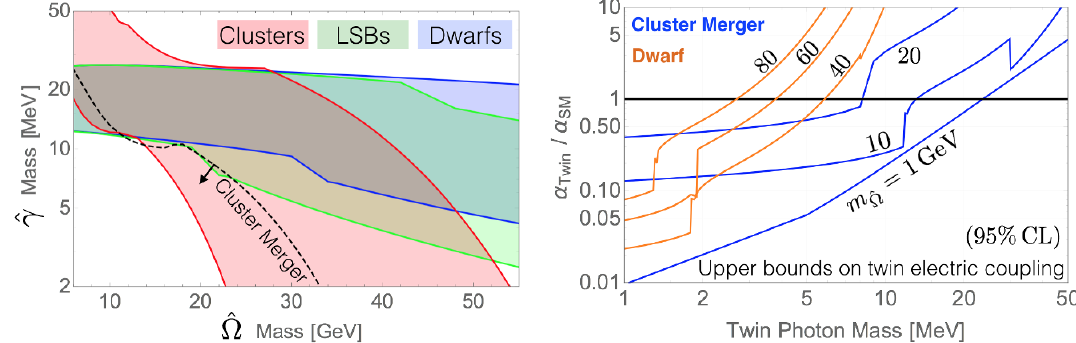
Figure 4 . Left: SIDM parameter space when considering only the dominant dark matter com- ponent ^(cid:10) and a Z 2 -symmetric twin photon coupling ^ (cid:11) = (cid:11) . See section 4 for the choice of cross section and velocity values. The dashed curve shows a lower bound on the dark matter mass from the cluster merger constraint. The overlap area (gray) among di(cid:11)erent allowed regions gives so- lutions to the mass de(cid:12)cit problem for the three types of galactic objects. Right: upper bounds on the twin electromagnetic coupling from the cluster merger and dwarf halo constraints. The kinks of the curves in both plots correspond to the transition points between di(cid:11)erent analytical approximation regimes in eq. (4.1) and (4.2) for the cross section calculation. For example, in the m ^(cid:10) = 10 GeV cluster merger curve, the (cid:12)rst kink from the left corresponds to (cid:12) ’ 1, and the second kink corresponds to m ^(cid:10) v=m ^ (cid:13) ’